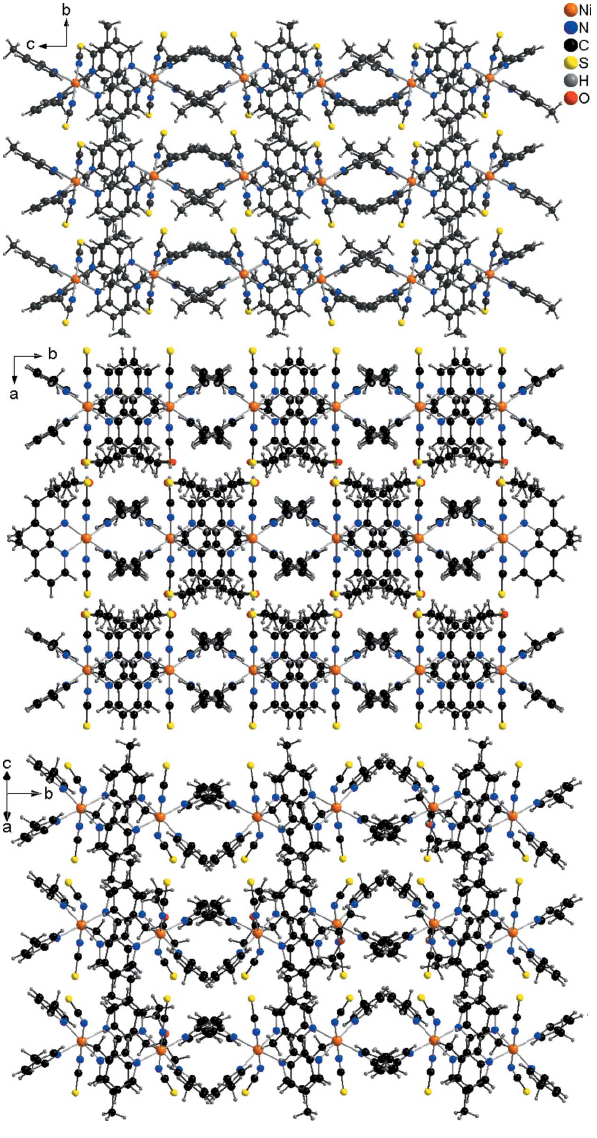
Figure 3 Crystal structure of the title compound drawn with DIAMOND (Brandenburg & Putz, 1999) with a view along the crystallographic a - axis (top) and of the compounds Ni(NCS) 2 (3-methylpyridine) 4 (cid:3) 2ethanol (mid) and Ni(NCS) 2 (3-methylpyridine) 4 (cid:3) diethyl ether (bottom) retrieved from the literature (Krebs et al. ,